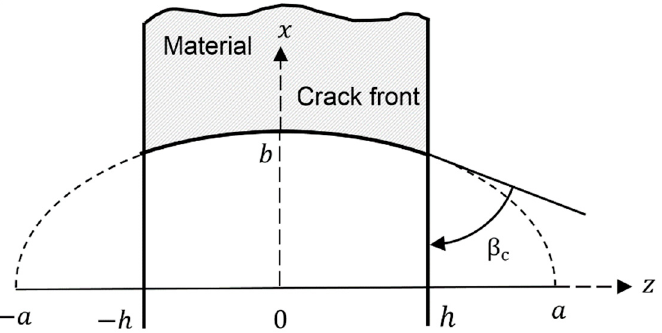
Figure 2. Elliptical-arc crack front shape for geometrical parameters crack propagation.